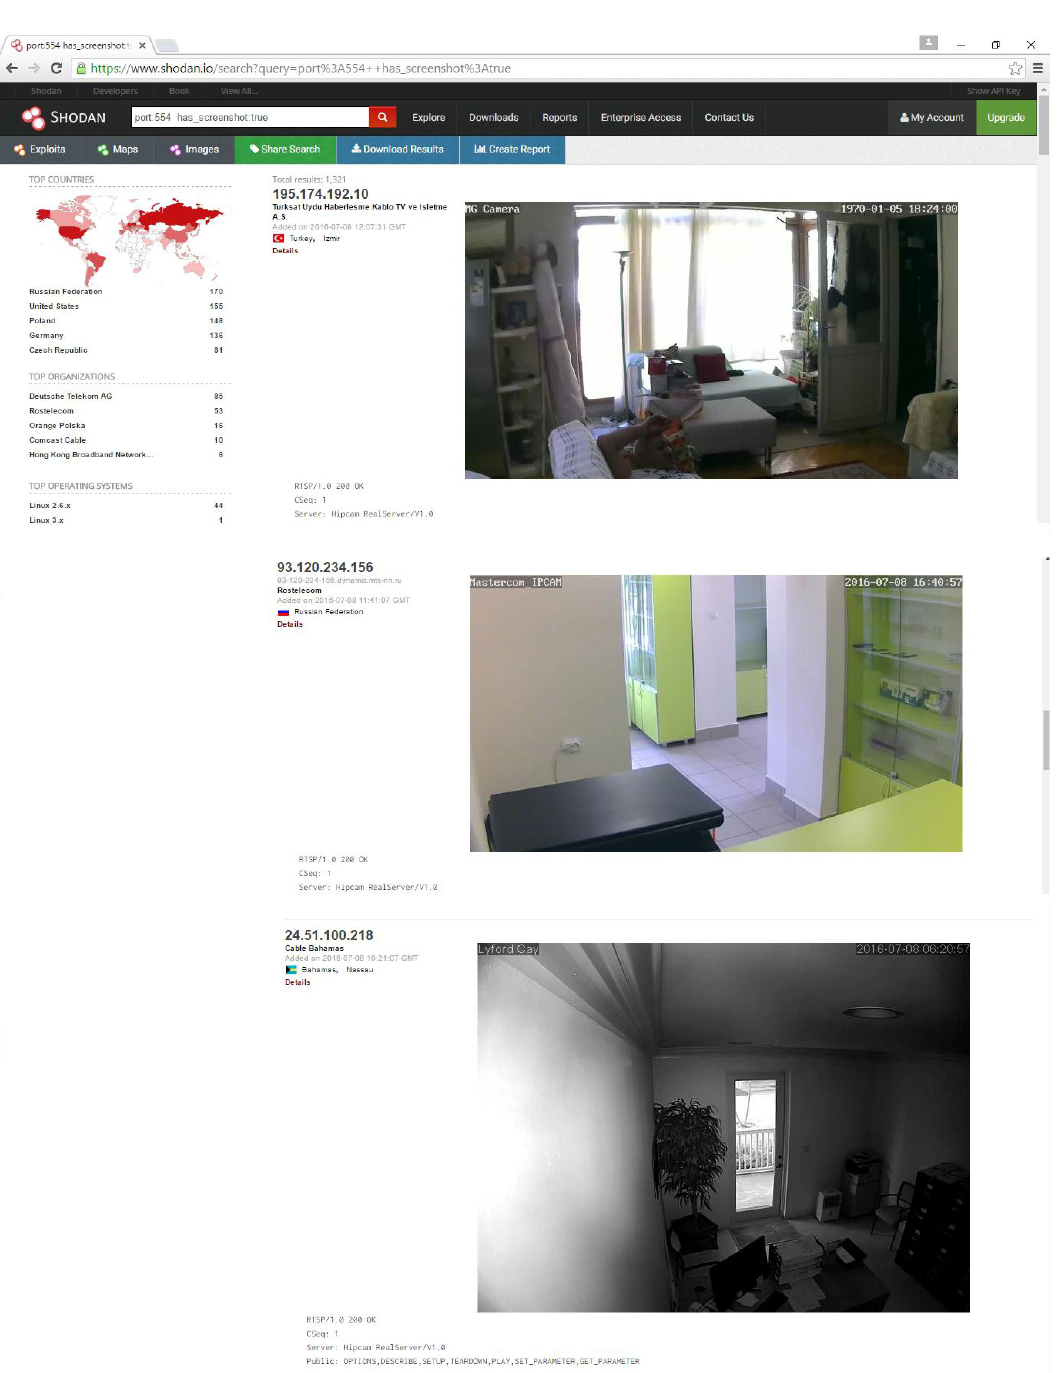
Figure 1. A list of home surveillance cameras from Internet device–scanning search engine Shodan.